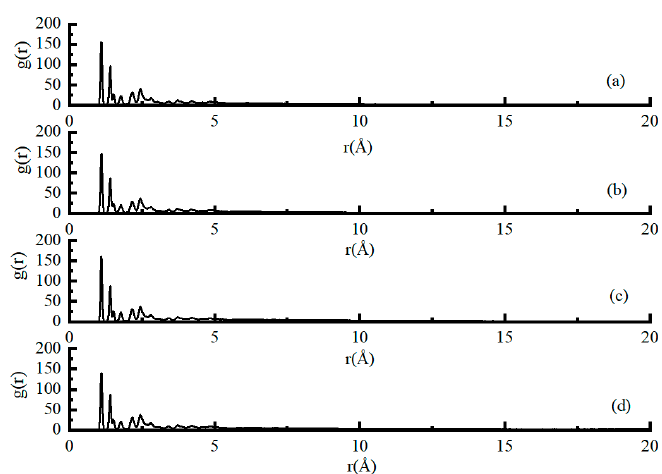
Figure 9. The radial distribution function for asphaltene-asphaltene, ( a ) granite/SCA-asphalt model, ( b ) granite-asphalt model, ( c ) basalt-asphalt, and ( d ) limestone-asphalt.